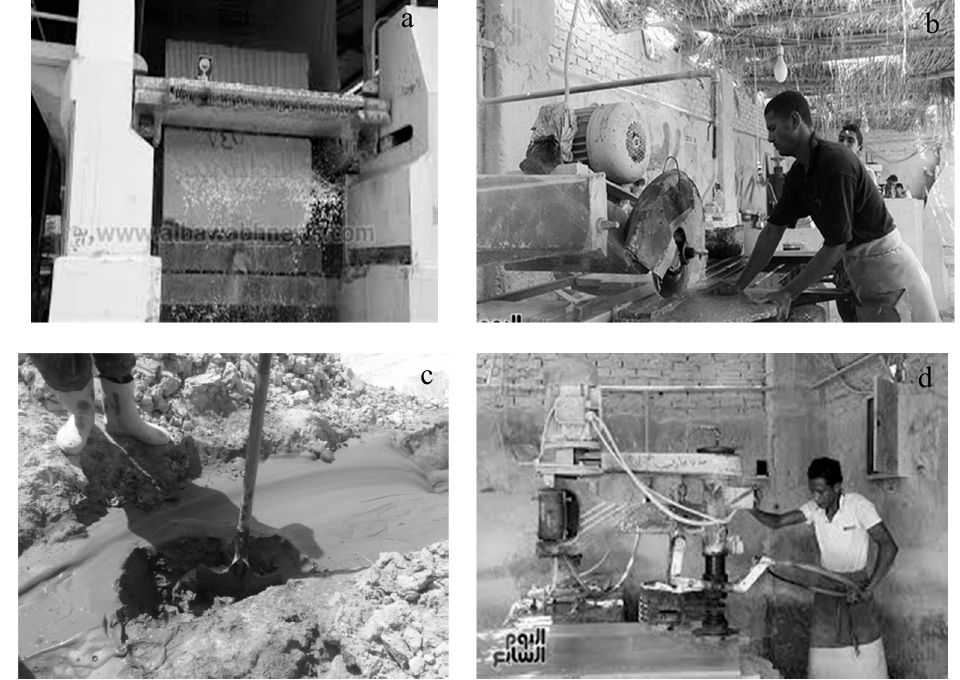
Figure 1. Photographs showing types of the cutting processes ( a , b ), marble cutting sludge ( c ), marble polishing process ( d ), Cairo, Egypt.